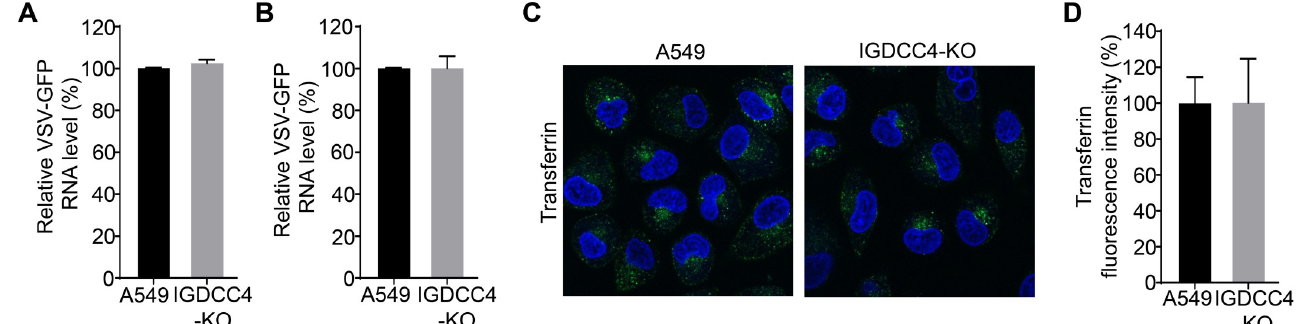
Fig 7. IGDCC4 does not affect the internalization of vesicular stomatitis virus-green fluorescent protein (VSV-GFP) and transferrin. The A549 cells and IGDCC4-KO cells infected with VSV-GFP at an MOI of 10 were incubated and washed differently before being collected for detecting viral attachment ( A ) or ( B ) internalization by using qRT-PCR, the values of IGDCC4-KO cells were normalized with that of A549 cells. Data shown are from three replicates (means ± SDs). ( C ) and ( D ) Internalization of transferrin in IGDCC4-KO and A549 cells were evaluated by incubating cells with 50 μ g/ml fluorescently labeled transferrin at 37˚C for 30 min before receiving an acid wash to quench extracellular transferrin and were subsequently processed for confocal microscopy. Automatic image analysis quantified a total of 100 cells in three independent experiments and normalized to the A549 cells. The data shown in A, B, and D are from three independent experiments or biological replicates (means ±